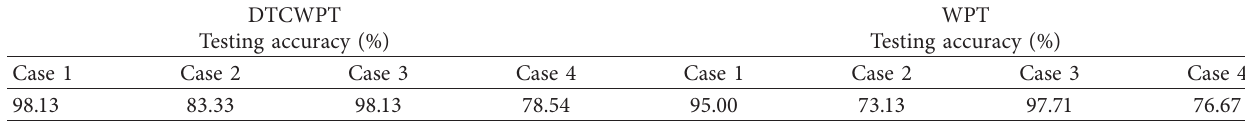
Table 5: Bearing fault diagnosis results obtained by